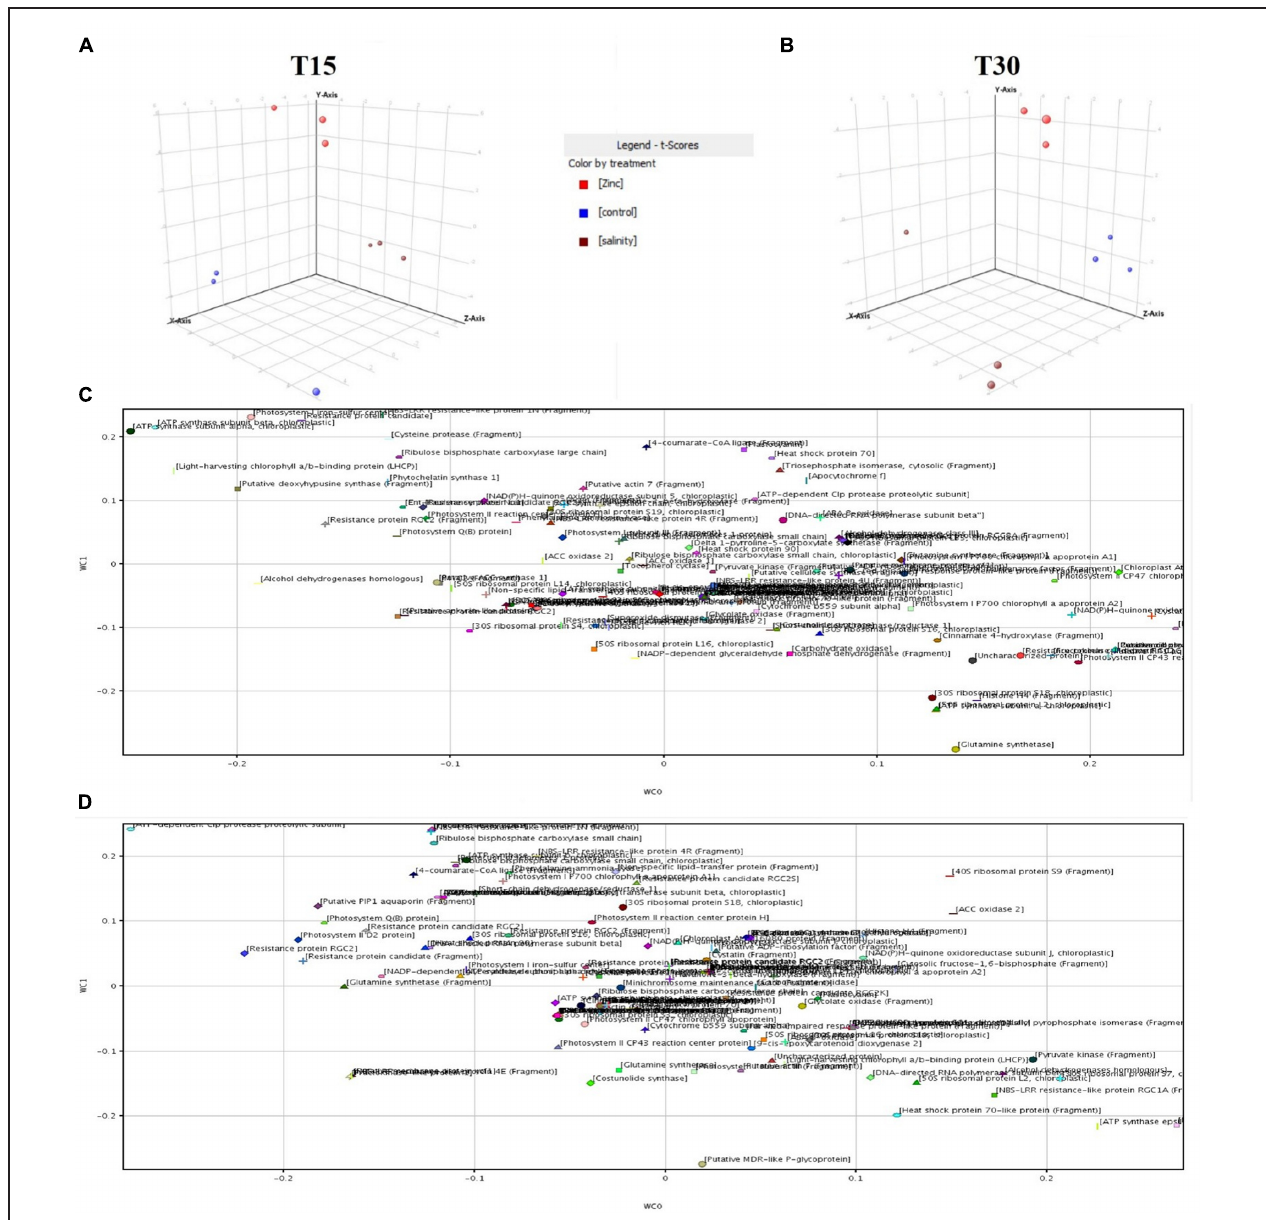
FIGURE 3 | Partial Least Squares Discriminant Analysis (PLS-DA) identification of proteins being significantly altered under zinc stress. (A,B) are the hyperspace plots from PLS-DA models at 15 and 30 days, respectively, while (C,D) are the class prediction loadings on first (WC0, x -axis) and second (WC1, y -axis) hyperspace